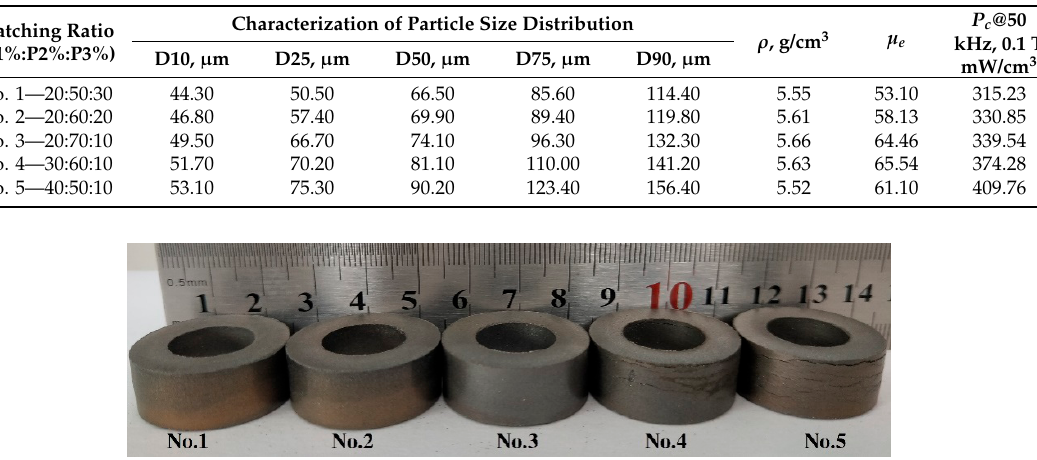
Table 1. Characterization of particle size distribution, green compact density, effective permeability, and core loss for the amorphous magnetic powder cores (AMPCs) with different matching ratios of P1%/P2%/P3%.